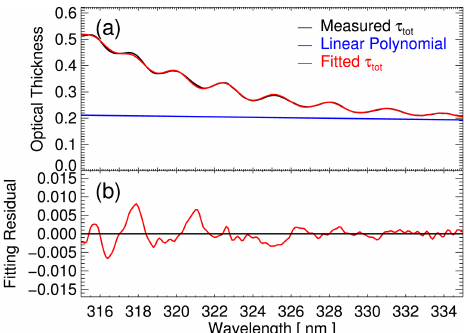
Figure B1. (a) Spectral fitting result of the SMART–s O 3 algo- rithm at 16:50UTC on 14 October 2019 measured on the rooftop of the NASA Goddard Space Flight Center Building 33 (38.99 ◦ N latitude, 76.84 ◦ W longitude). Panel (b) presents the fitting residual (measured optical thickness subtracted by model optical thickness).